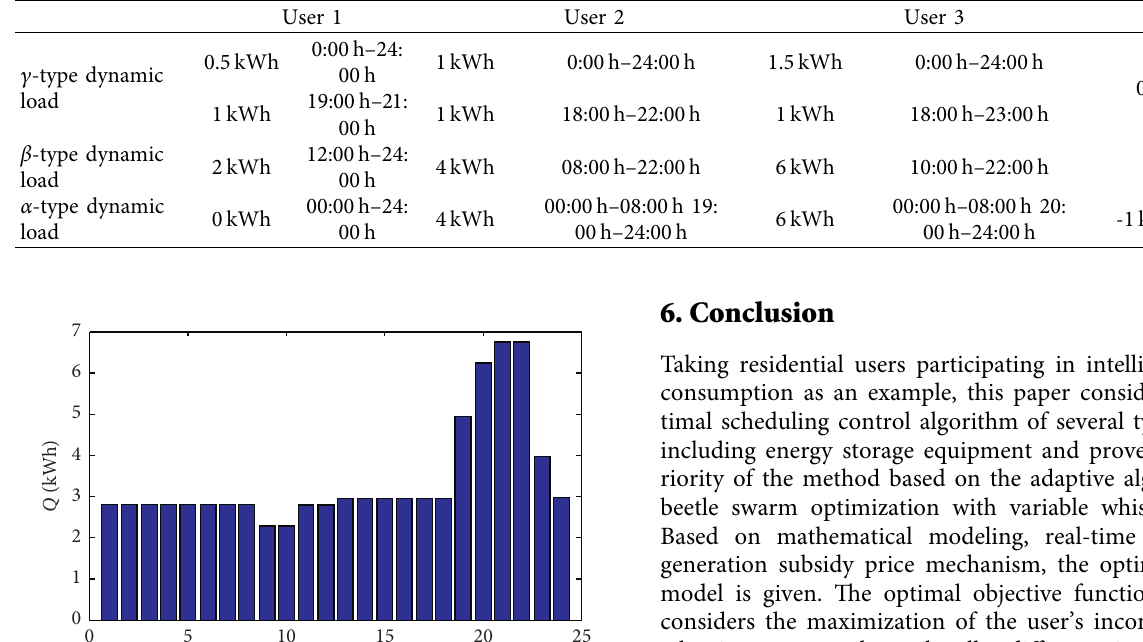
Table 1: Electricity load information of all users.